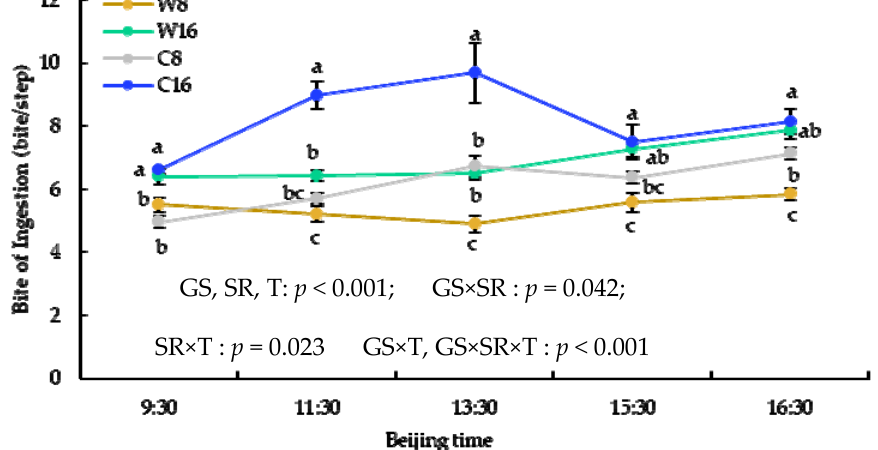
Figure 6. The x–axis is the time of day, and the y–axes is the bite of ingestion. GS = grazing season; SR = stocking rate; T = times.